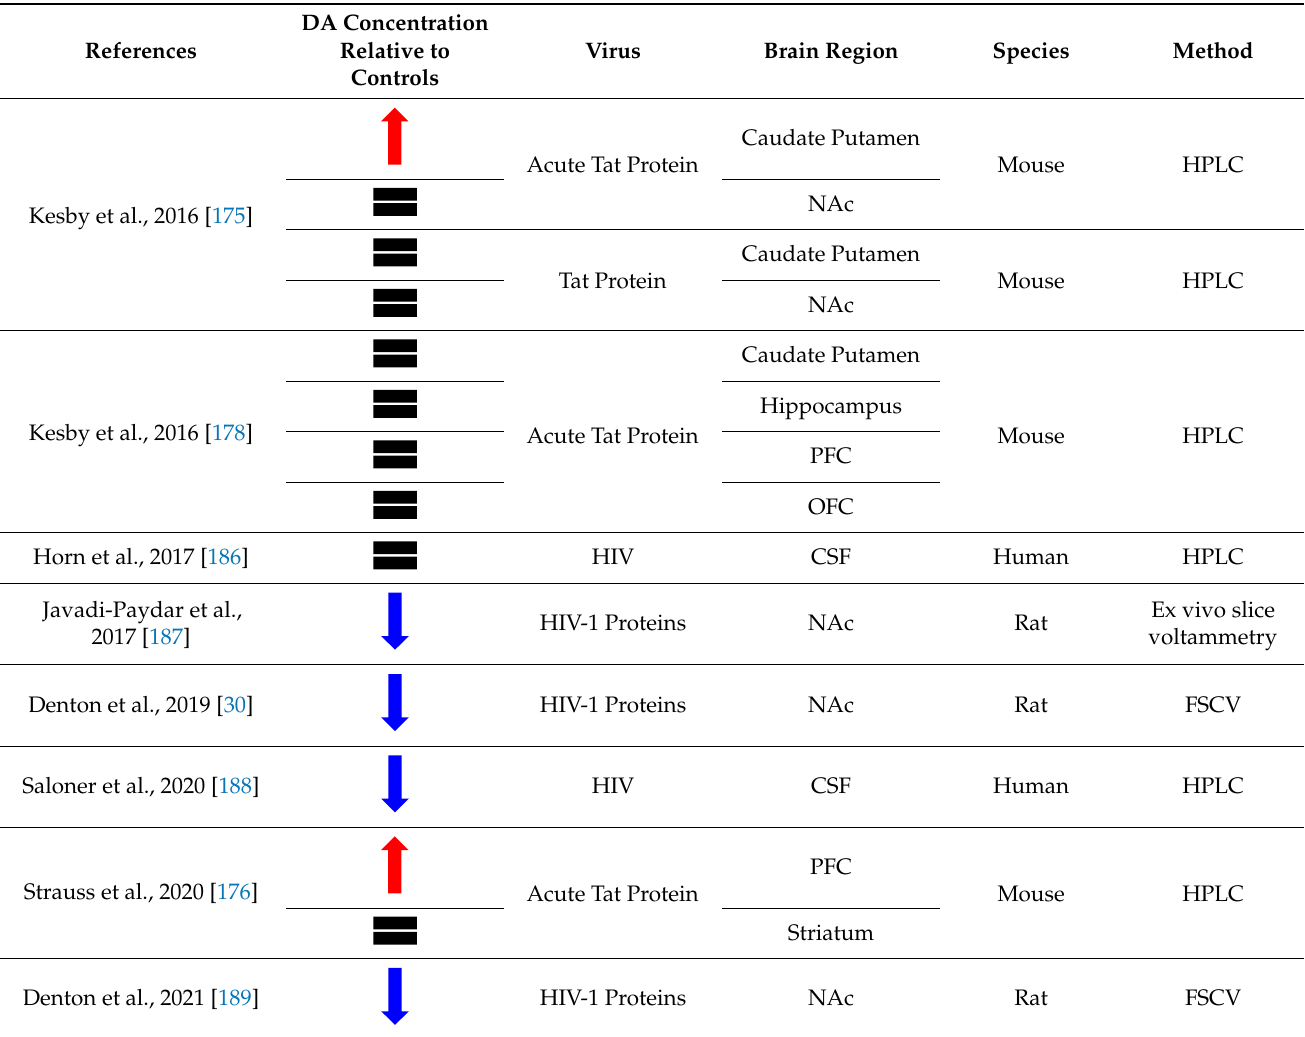
Denton et al., 2021